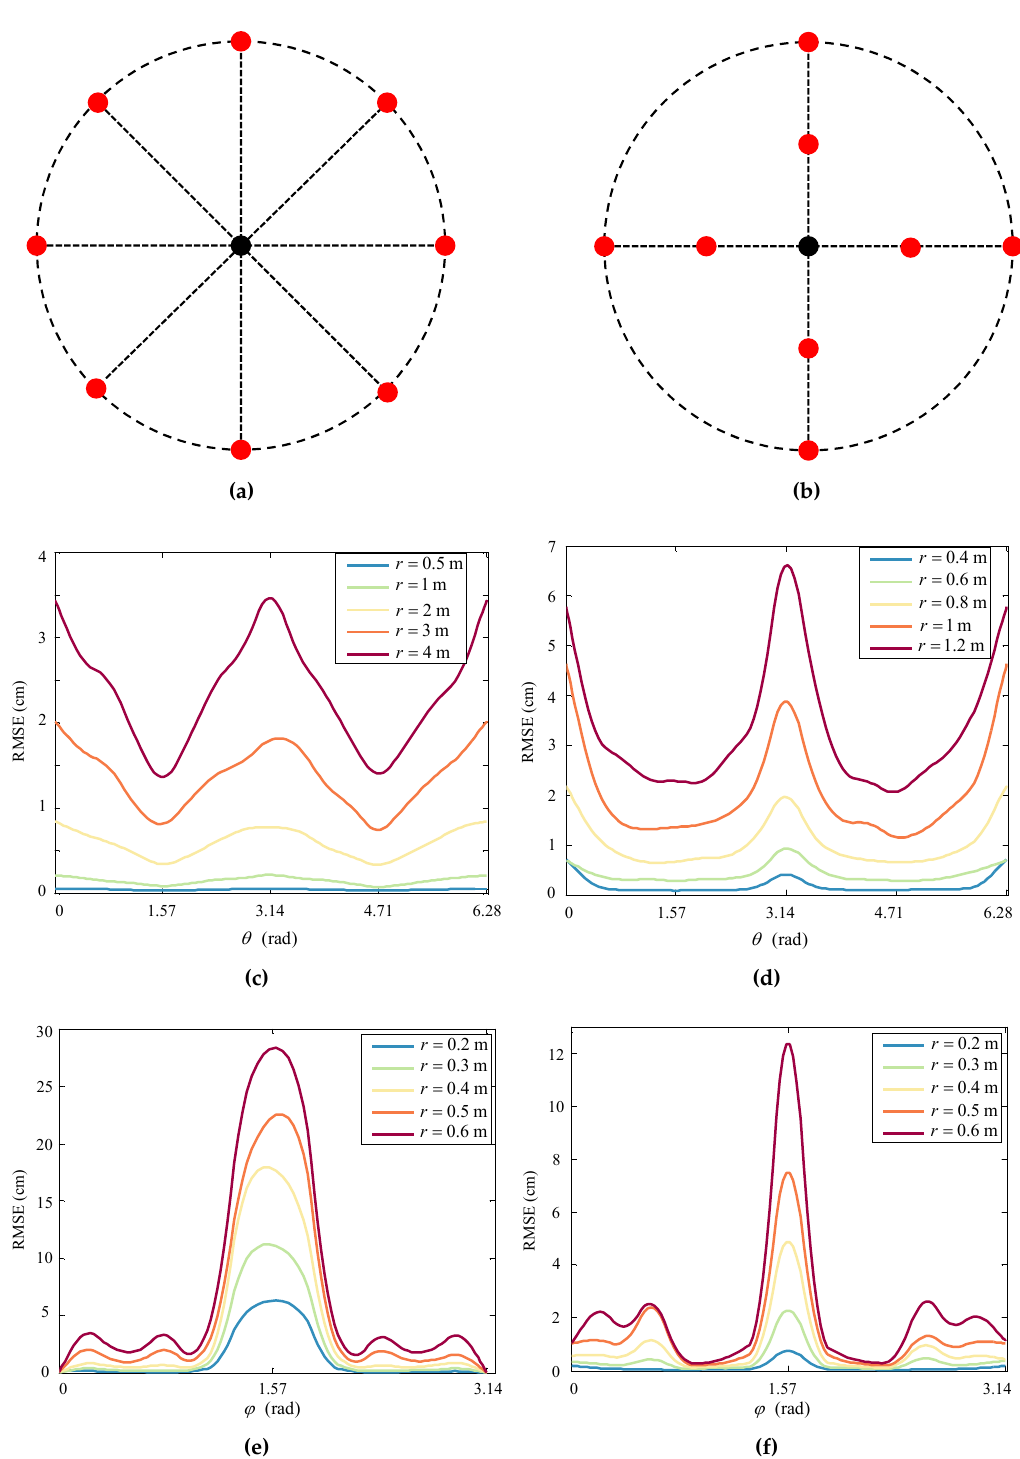
Figure 6. ( a ) The uniform circular electrode configuration; ( b ) The cross-shaped electrode configuration ( c ) Positioning error of uniform circular electrode configuration in the plane xOy; ( d ) Positioning error of the cross-shaped electrode configuration in the plane xOy; ( e ) Positioning error of uniform circular electrode configuration in the plane xOz; ( f ) Positioning error of the cross-shaped electrode configuration in the plane